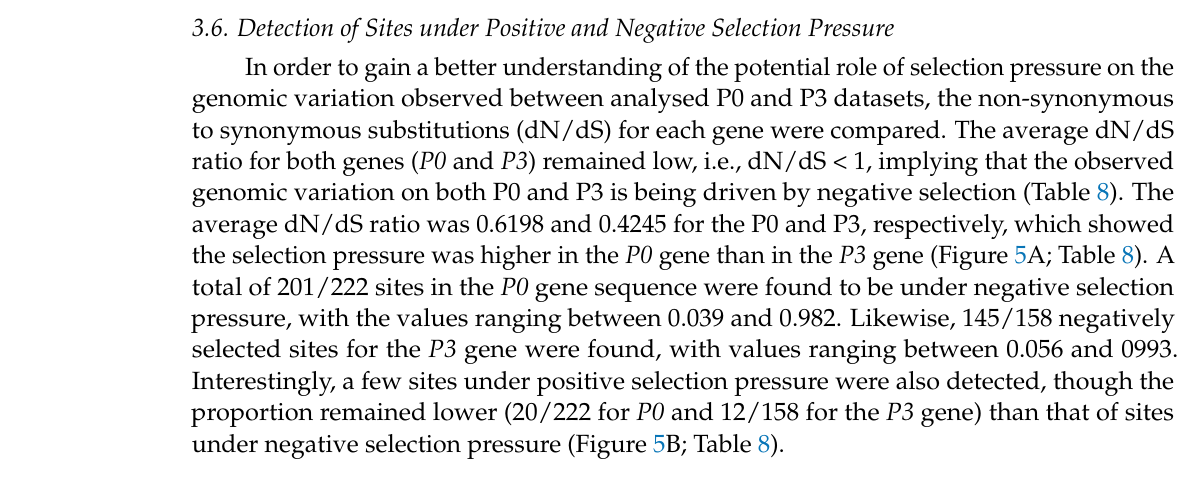
Table 8. Estimation of average dN/dS ratios, positive and negative selection pressures within P0 and P3 genes of TuYV